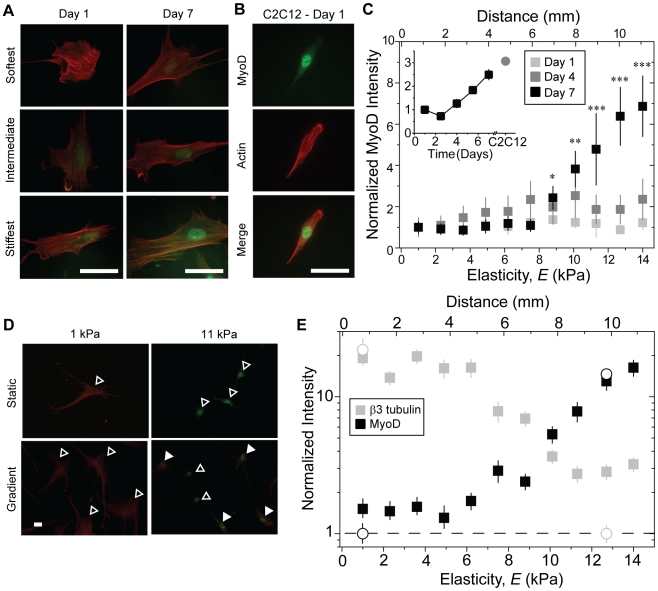
MSC expression of lineage markers as a function of time on gradient hydrogels.(a) Immunofluorescent staining for MyoD (green) and phalloidin (red) observed as a function of culture time and stiffness in MSCs cultured on gradient hydrogels. (b) Quantification of MSC nuclear immunofluorescent intensity over time and gradient position. Intensity was normalized to MSCs at the coverslip edge and shown as a fold change. Inset plot shows quantification of MSC nuclear immunofluorescent intensity (black squares) for cells cultured on static 11 kPa hydrogels over time. Nuclear immunofluorescent intensity of C2C12 myoblasts (gray circle) cultured for 1 day on static 11 kPa hydrogels is also shown. Intensity for all cells was normalized to MSCs at day 1. *p<10−2, ** p<10−3, *** p<10−4 compared to both days 1 and 4. (c) Immunofluorescent staining for MyoD (green) and phalloidin (red) in a C2C12 myoblast cultured for 1 day on a static 11 kPa hydrogel. (d) MSCs were cultured on 1 and 11 kPa static (top) and gradient (bottom) hydrogels and stained for β3 tubulin (red) and MyoD (green). Open arrowheads indicate cells expressing either β3 tubulin or MyoD while filled arrowheads indicate doubly stained cells. (e) MSC fluorescent intensity on gradient hydrogels (filled squares) was quantified for β3 tubulin (grey) and MyoD (black) and normalized to the non-permissive static hydrogel (open circles), i.e. β3 tubulin and MyoD intensities were normalized to MSC intensity on static 11 and 1 kPa hydrogels, respectively. The dashed line indicates no change from the non-permissive hydrogel of that protein. All scale bars are 12.5 µm.